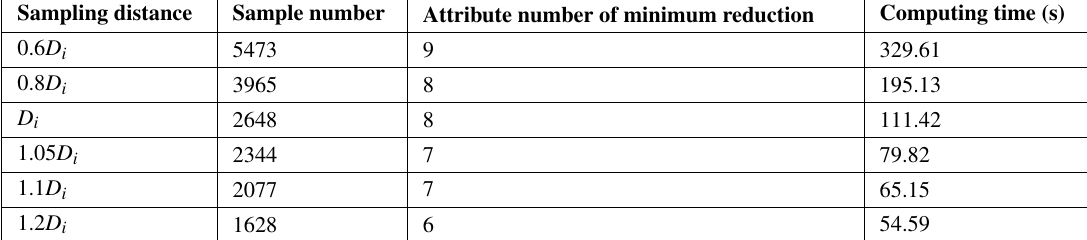
Table 4 The relationship between different sampling distances and reduction effectiveness for Statlog.